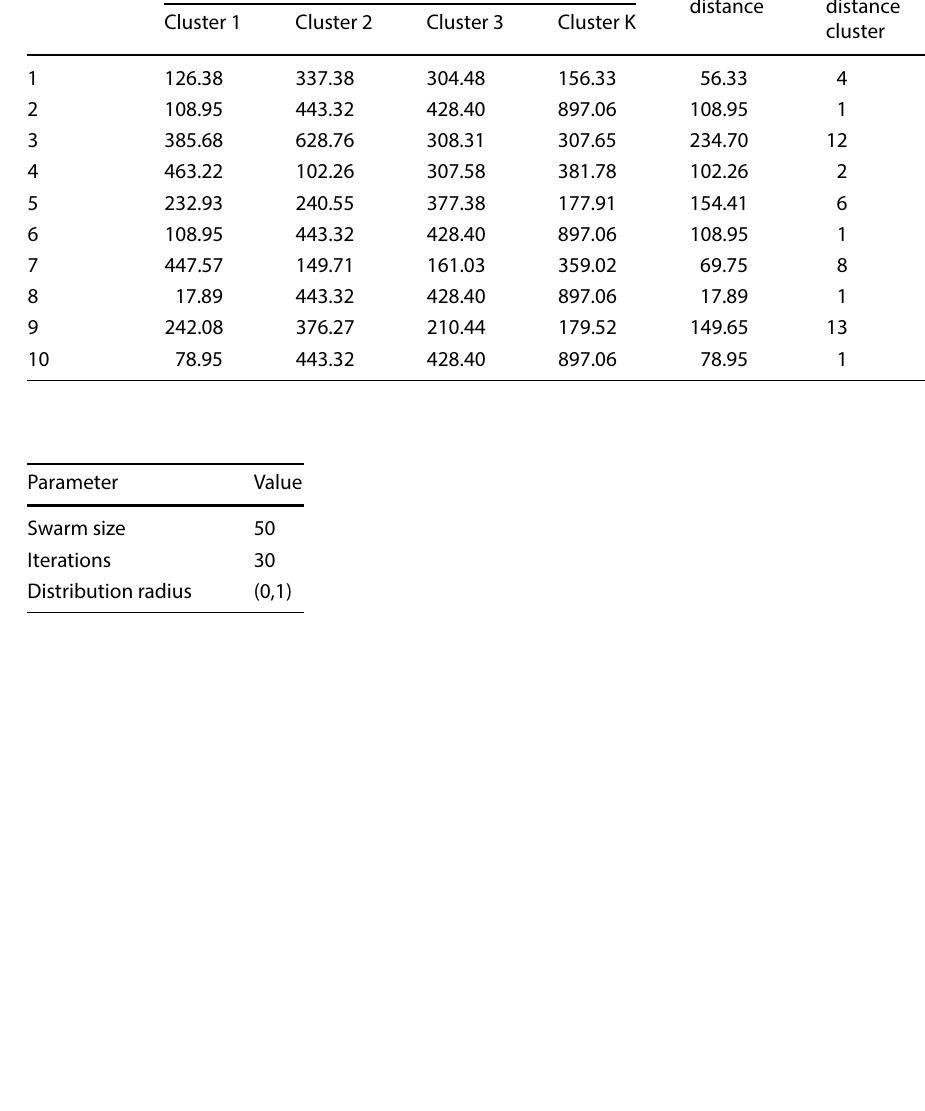
Table 5 Performance of FCMRP on UNSW-NB15 dataset